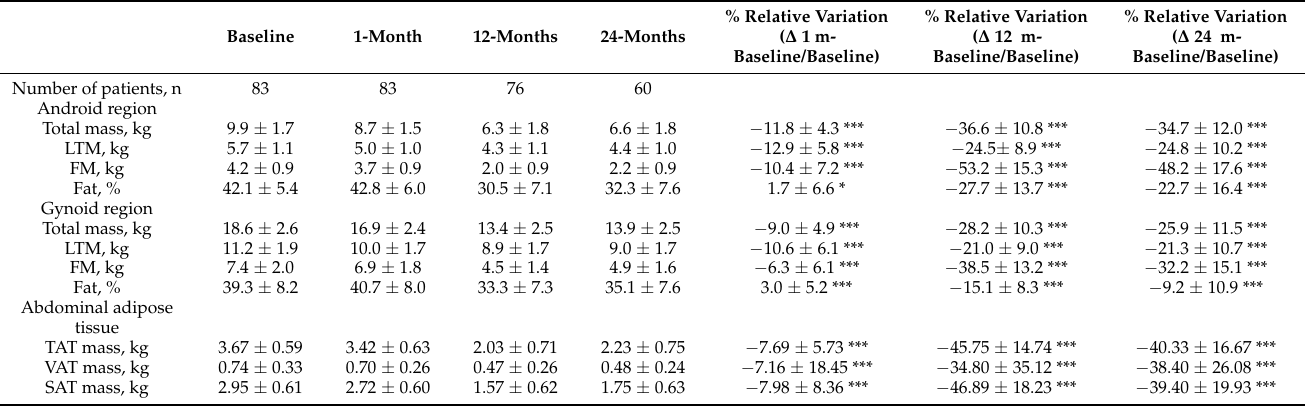
Table 3. Android, gynoid and abdominal adipose tissue at baseline and 1, 12 and 24 months after sleeve gastrectomy.